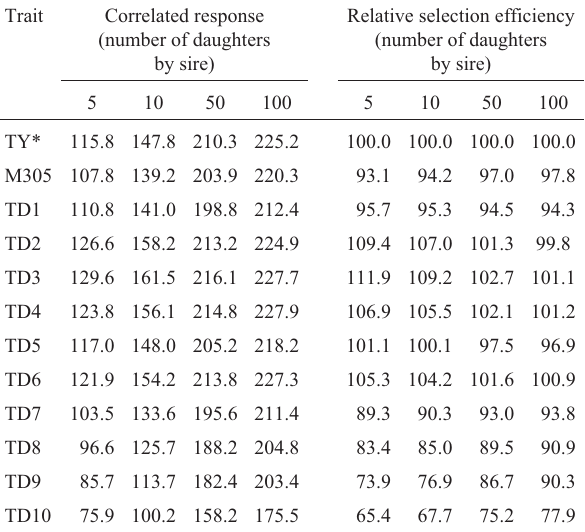
Table 4 - Expected direct response to selection for total milk yield (TY) and correlated response for total milk yield with direct selection for test-day milk yield (TD) and relative selection